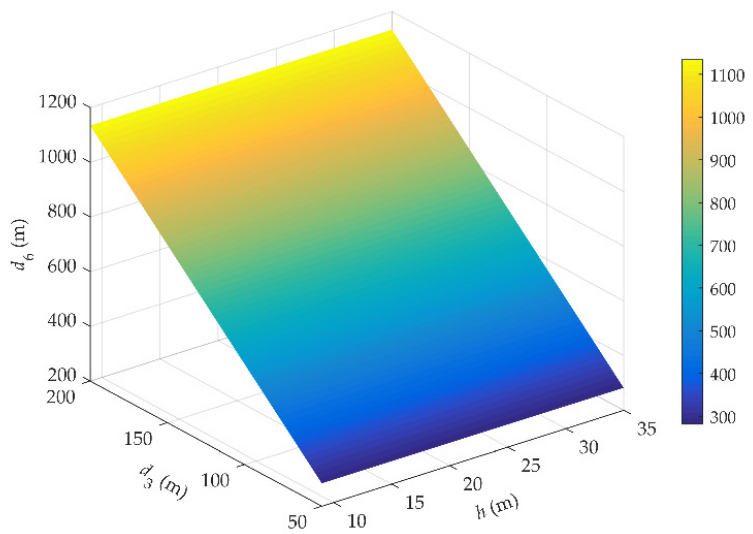
Figure 13. Relationship between h , d 3 and d 6 .